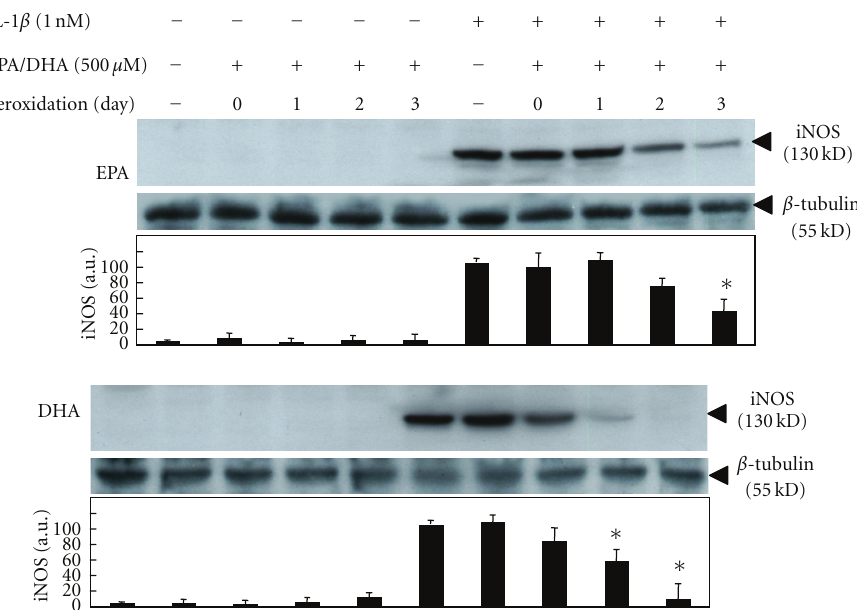
∗∗ Figure 5: E ff ects of peroxidized EPA/DHA on the expression of iNOS protein. Cells were treated with IL-1 β (1nM) in the presence or absence of peroxidized EPA and DHA (each, 500 μ M) for 6h. Cell lysates (25 μ g of protein) were subjected to SDS-PAGE in a 7.5% gel, and immunoblotted with an anti-iNOS or anti- β -tubulin antibody. The bands corresponding to iNOS were quantitated by densitometry, and the levels of iNOS were normalized by those of β -tubulin (lower, mean ± SD, n = 3 experiments; ∗ P < . 05 versus IL-1 β alone).